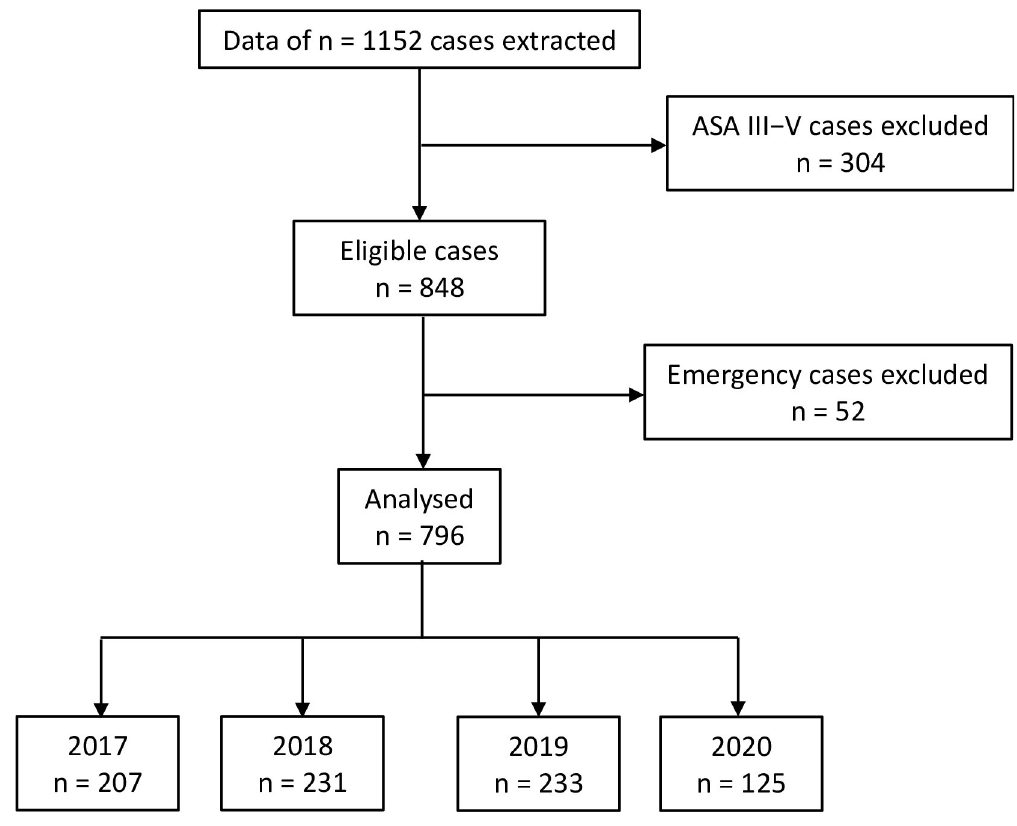
Fig 1. Study flow diagram according to